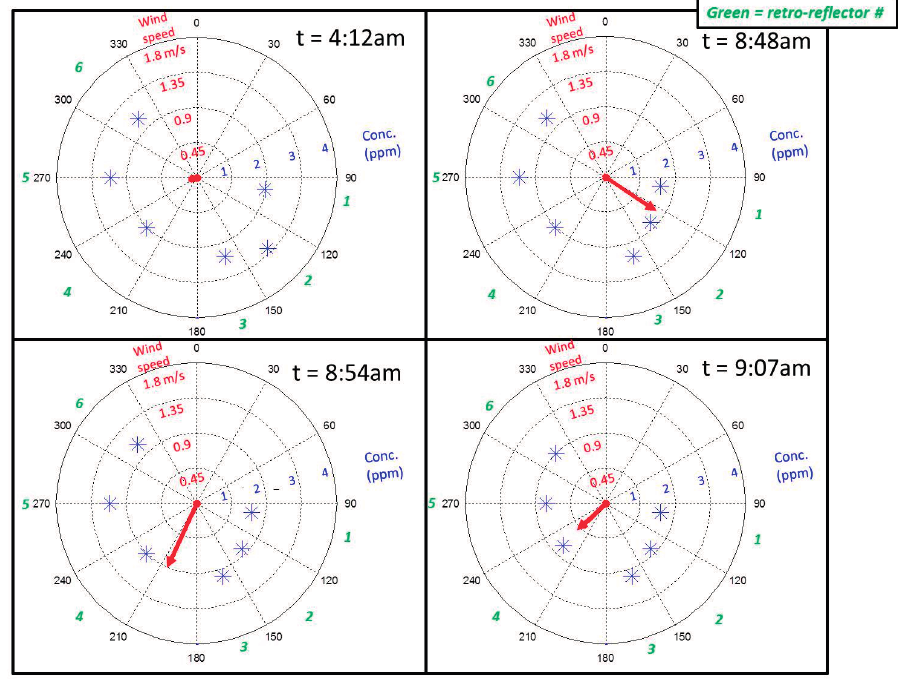
Figure 9. Illustration of observed mixing, and the corresponding decrease in measured CH 4 concentration, resultant from the onset of winds with speed greater than 0.45 m/s, which on 3 August 2013 occurs just before 09:00, local time. The red vector and blue stars indicate the magnitude and direction for the wind and CH 4 concentration measurements, respectively, while the green numbers indicate where each sample path is located with respect to the wind